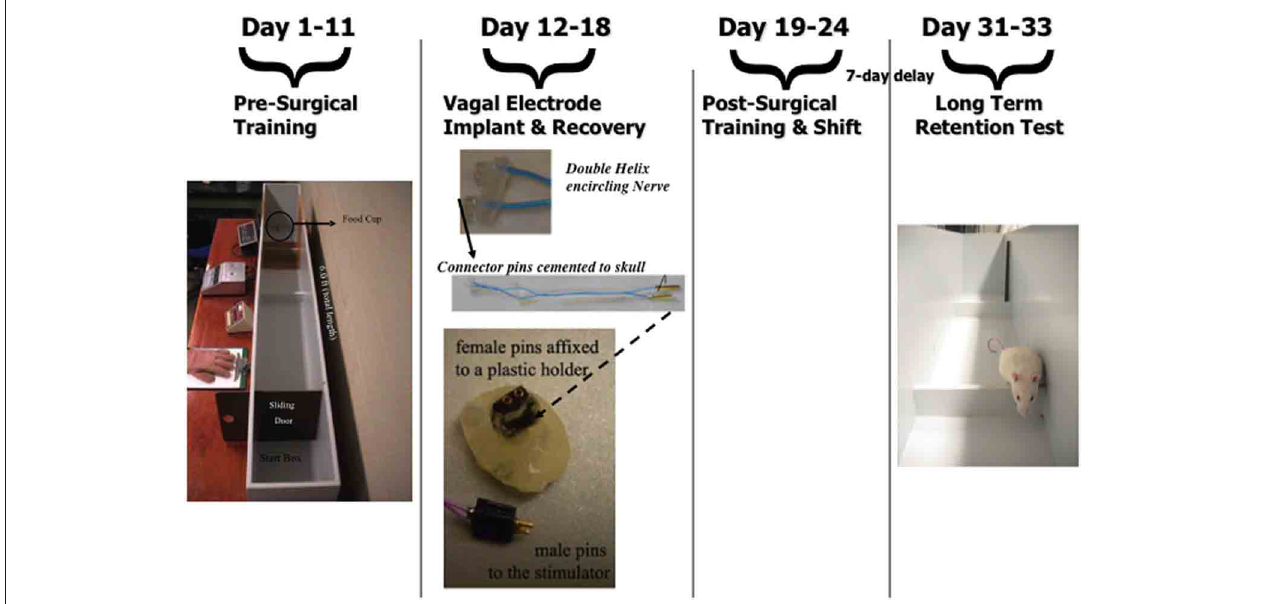
FIGURE 1 | Time line for the training and testing regimen in the straight alley learning task and dimensions of the training apparatus. Illustration of the electrode implanted along the vagus nerve to produce vagal nerve stimulation.